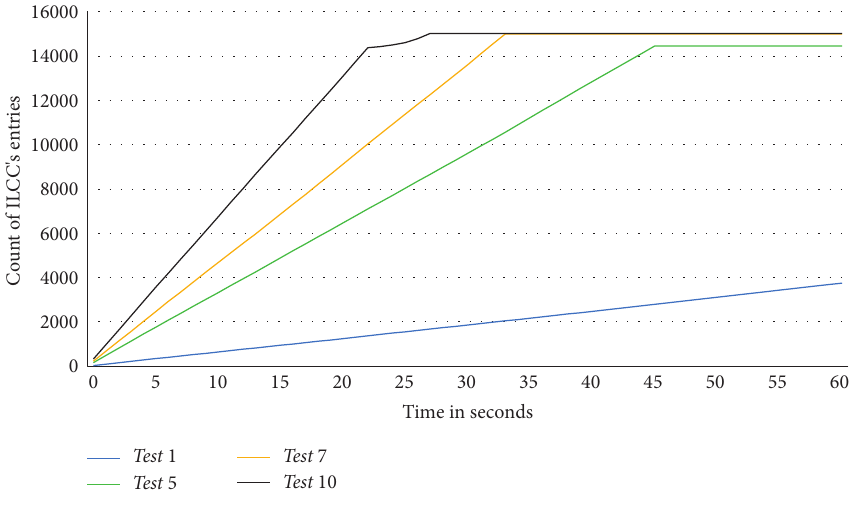
Figure 4: ILCC growth over transport layer